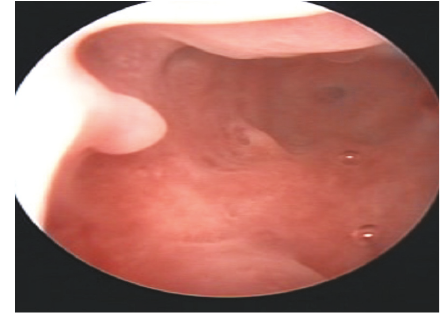
Figure 1: Hysteroscopy findings.